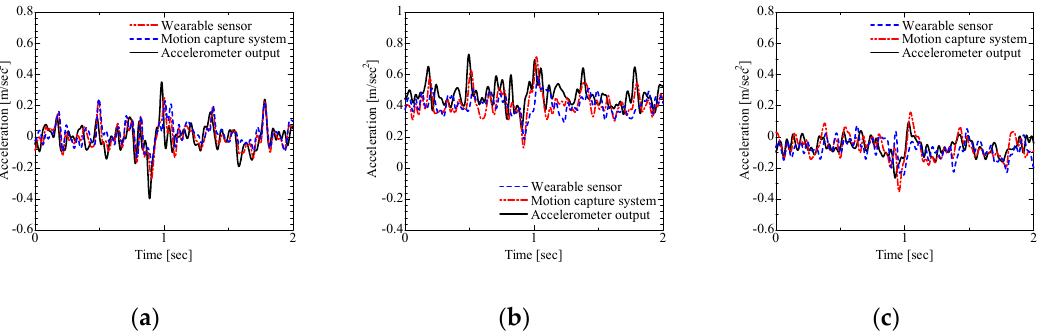
Figure 6. Results for acceleration calculated using the wearable sensor, the motion capture system, and the accelerometer outputs; ( a ) Acceleration of the ankle joint from the wearable sensor attached to the lower thigh; ( b ) Acceleration of the knee joint from the wearable sensor attached to the femur; ( c ) Acceleration of the hip joint from the wearable sensor attached to the